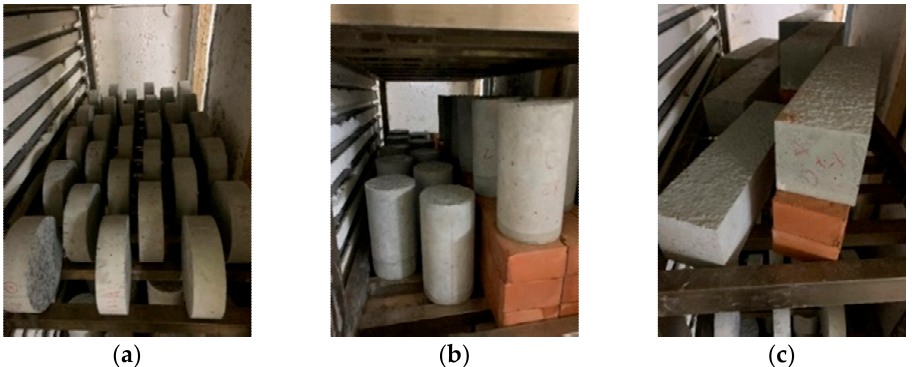
Figure 5. Configurations of specimens in high-temperature furnace: ( a ) water-penetration-test specimens; ( b ) compressive-strength-test specimens; ( c ) flexural-strength-test specimens.